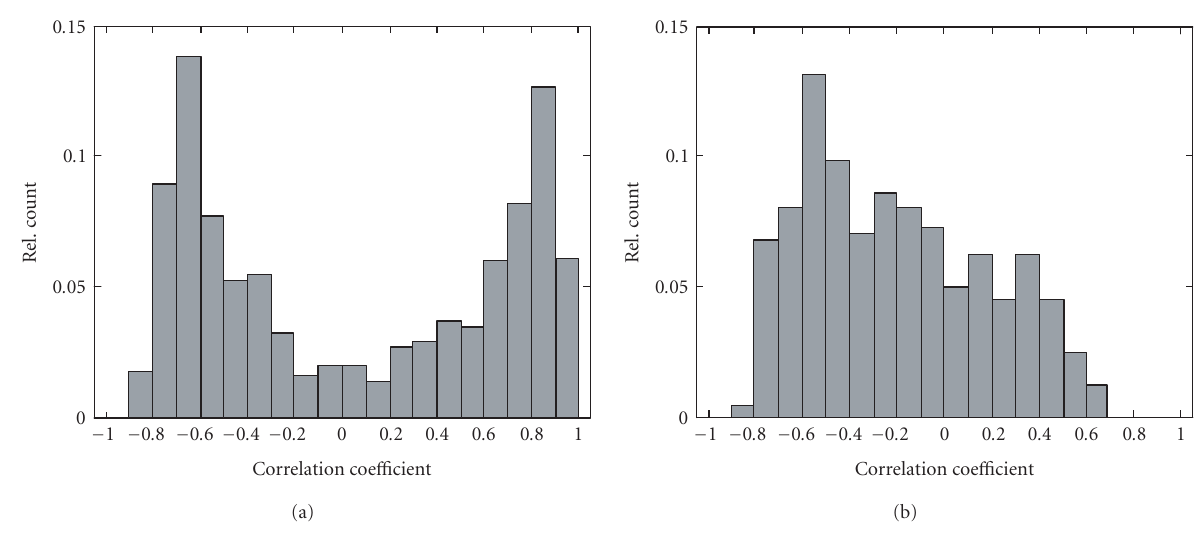
Figure 11: (a) Histogram of all (real-valued) slow fading interferer correlation coe ffi cients measured in the new building indoors. (b) Values in star BS configuration in the old building